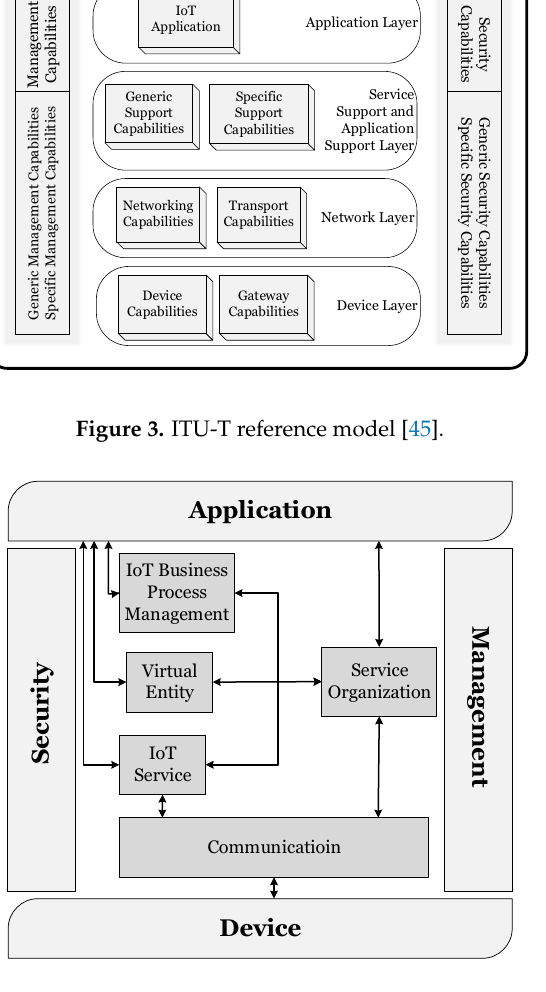
Figure 4. IoT-A functional view